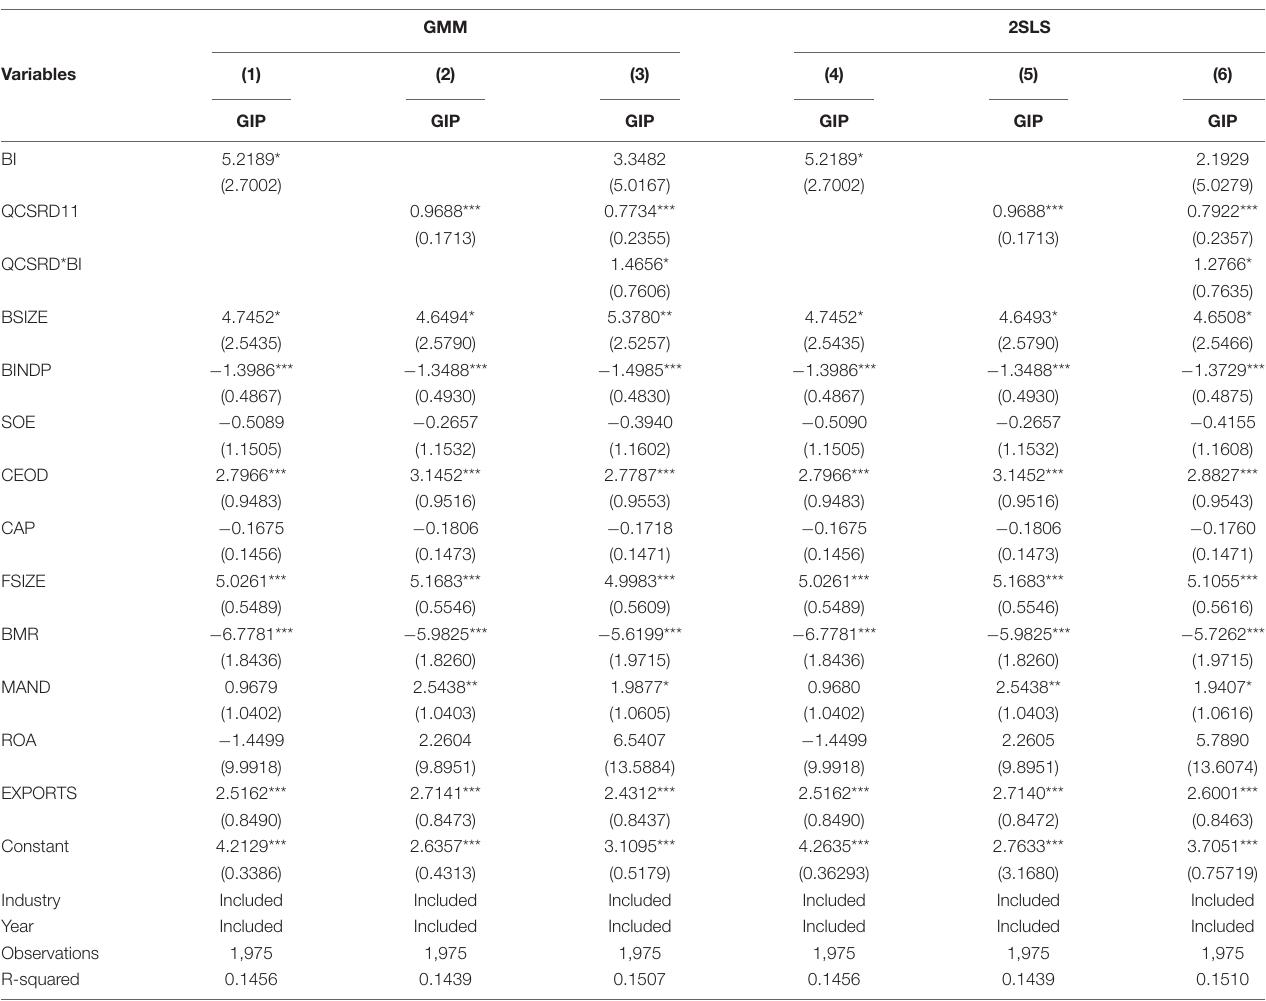
TABLE 4 | Regression results based on GMM and 2SLS